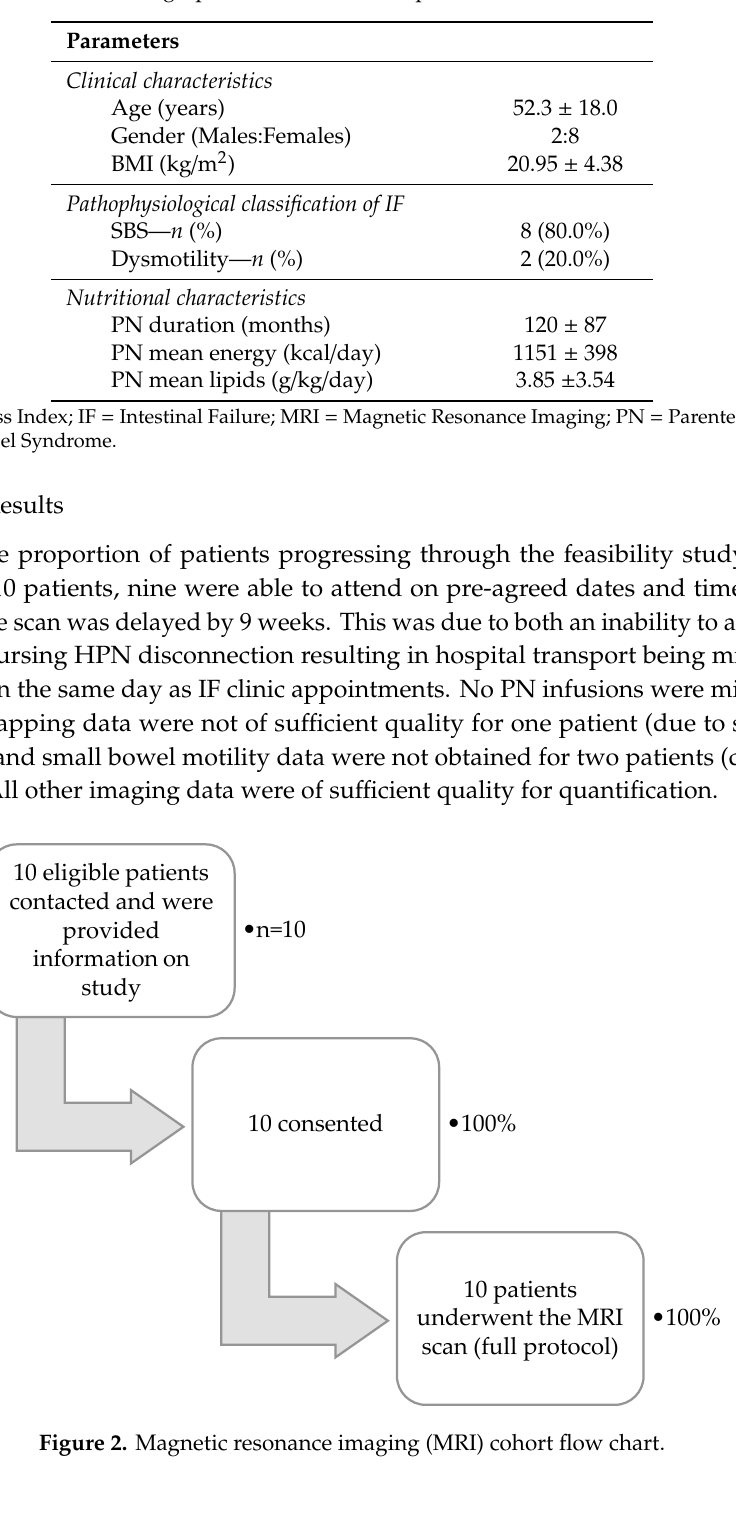
Table 5. Demographic characteristics of patients in the MRI Cohort.